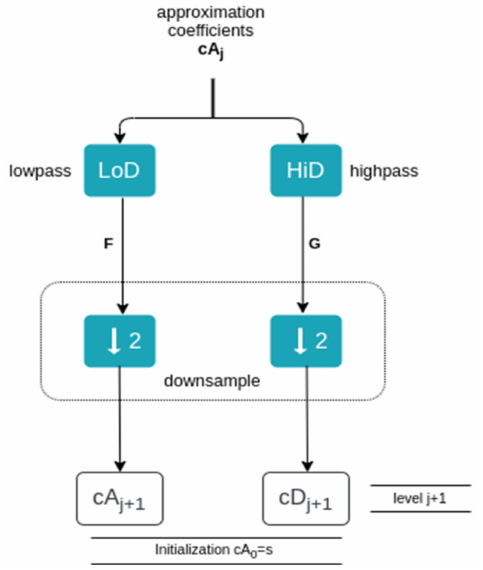
Figure 2. The 1D wavelet decomposition algorithm (wavedec function).